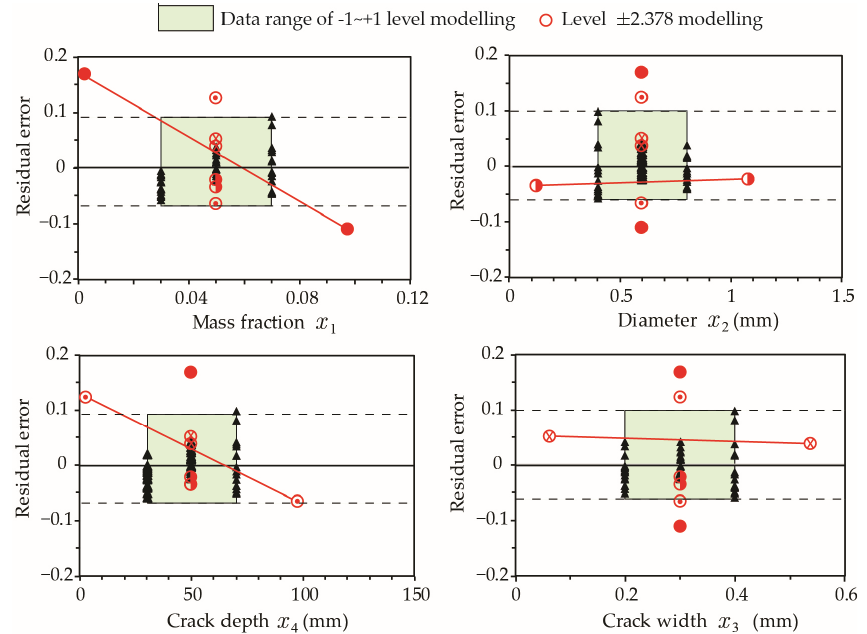
Figure 8. Influence of individual factors on residual errors of model-P h . The results of extreme cases at Level ±2.378 are connected by a red line.